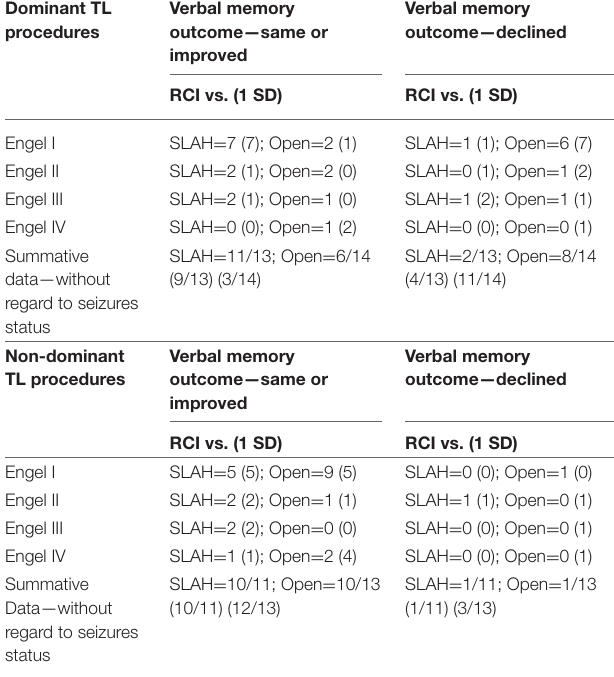
TABLE 4 | Change in verbal memory by surgery type, laterality of procedure, and seizure outcome excluding atypical language cases. Dominant TL